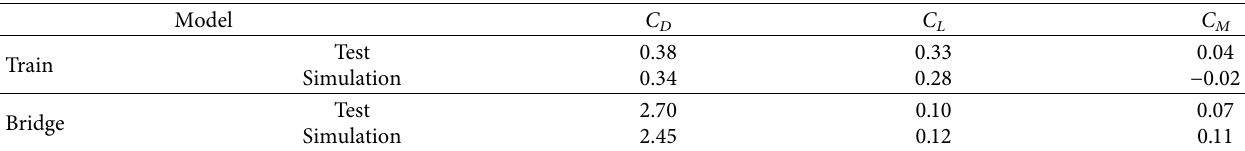
Figure 3: Meshes of the model. (a) Overset mesh around the train. (b) Cross section mesh. (c) Mesh around the barrier. Table 1: Comparison of results from tests and CFD